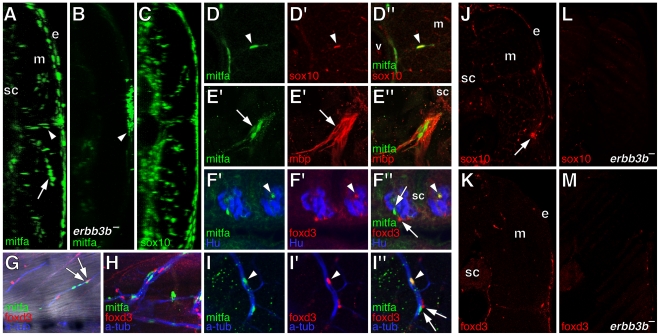
Extra-hypodermal cells expressing mitfa::GFP, foxd3, and sox10 in
wild-type larvae and their deficiency in erbb3b
mutants.All images are from early metamorphic (6.2–8.0 SSL) wild-type
larvae except for B, L, and M, from erbb3b mutant
larvae. (A–C) Transverse confocal projections (collapsing ∼1.5
mm of trunk along the anterior-posterior axis) showing GFP+ cells
in living larvae (left side of each larva is shown). Images correspond
to Videos S1, S2, S3.
(A) mitfa::GFP+ cells in a wild-type fish occur in the hypodermis,
between the epidermis (e) and the myotome (m), within the the myotome
itself (arrow), and above the spinal cord (sc). Arrowhead, location of
the horizontal myoseptum. (B) In erbb3b mutants, most
mitfa::GFP+ cells were missing. This image is intentionally
overexposed compared to A, revealing faint reflected fluorescence from
iridescent iridophores in the hypodermis (arrowhead), which are present
in wild-type larvae as well. (C) sox10::GFP+ cells were found in
extra-hypodermal locations of wild-type
Tg(−4.9sox10:egfp)ba2 larvae
[98]. (D–M) Immunohistochemical analyses of
fixed specimens. (D) Co-expression of mitfa::GFP (green) and sox10
(red). v, vertebral column. (E) mitfa::GFP+ cells aligned with
mbp+ glia (red) along ventral root motor fibers. Arrow,
mitfa::GFP+ cells did not co-express mbp. (F) Lateral view showing
mitfa::GFP+ cells and foxd3+ cells (red) between Hu+
neurons (blue) of dorsal root ganglia. mitfa::GFP+ and foxd3+
cells were often found close to one another (e.g., arrows) whereas other
cells co-expressed mitfa::GFP and foxd3 (arrowhead). (G) Lateral view
with superimposed brightfield and fluorescence images showing
mitfa::GFP+ and foxd3+ cells along a peripheral nerve fiber
stained for acetylated alpha tubulin (blue) within the myotome. Arrows,
adjacent mitfa::GFP+ and foxd3+ cells. (H). A nerve plexus
near the base of the caudal fin harbored numerous mitfa::GFP+ and
foxd3+ cells. (I) Along a peripheral nerve within the myotome some
cells co-expressed mitfa::GFP and foxd3 (arrowhead), whereas cells
expressing either mitfa::GFP+ or foxd3+ were often juxtaposed
(arrows). (J,K) Transverse sections through the dorsal trunk showing
sox10+ cells (J) and foxd3+ cells (K) n the hypodermis, within
the myotomes, and near the spinal cord. Arrow, lateral line nerve. (L,M)
In erbb3b mutant larvae, very few sox10+ (L) or
foxd3+ (M) cells were found.